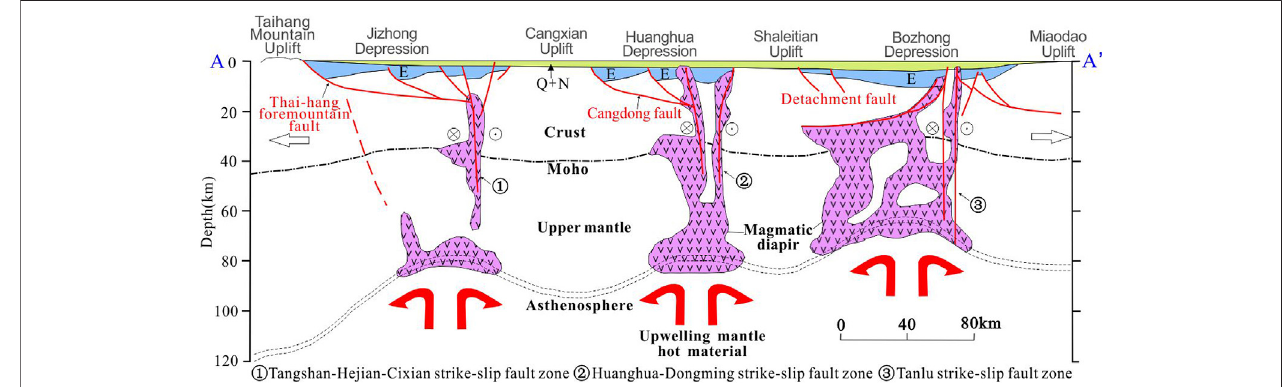
FIGURE3| SchematicdiagramofthetectonicsectionoftheBohaiBaybasin(see Figure2 forthecontentofthesectionline,afterXiaetal.,2012;see Figure1 for section).